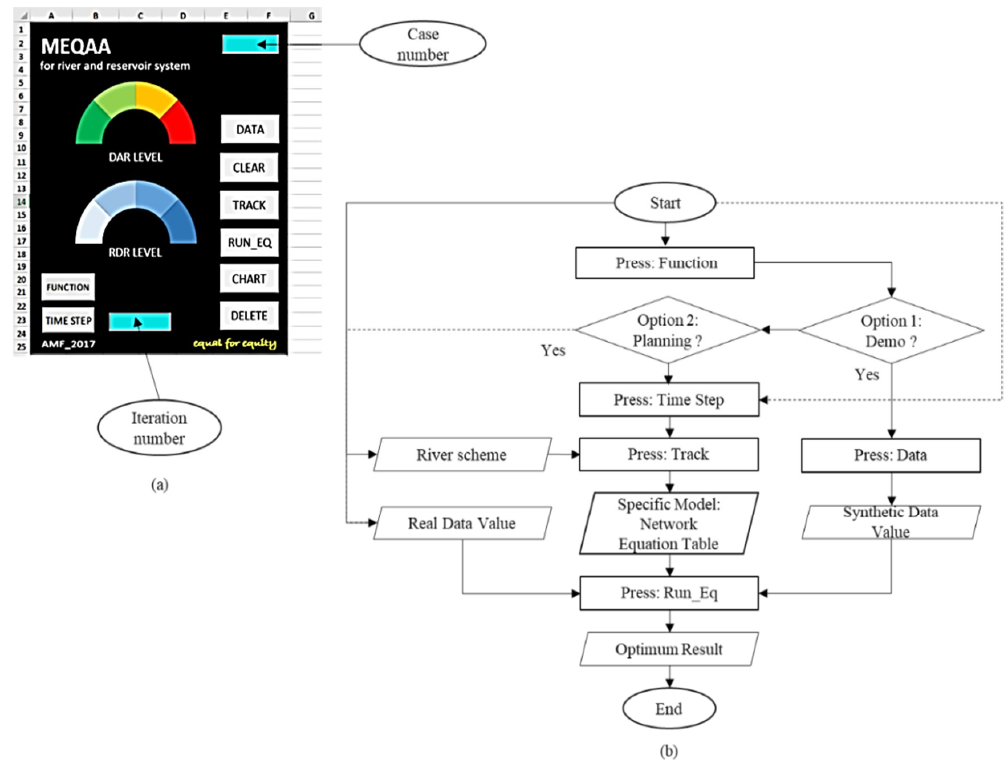
Figure 8. ( a ) MEQAA user interface facility with instruction buttons; ( b ) Standard operating procedures of